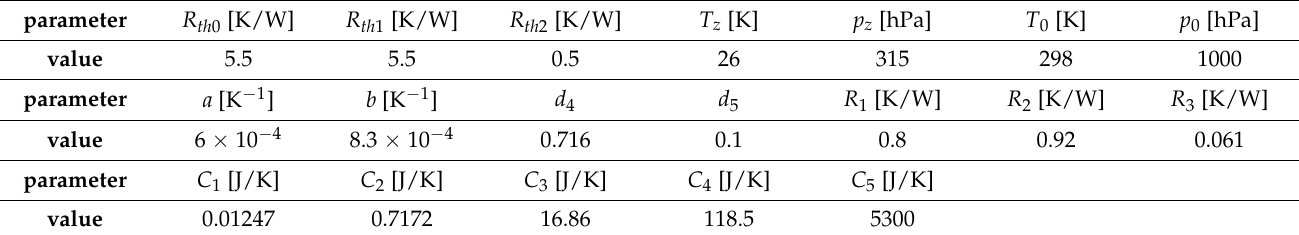
Table 1. Values of the parameters of the thermal model of the tested diode.